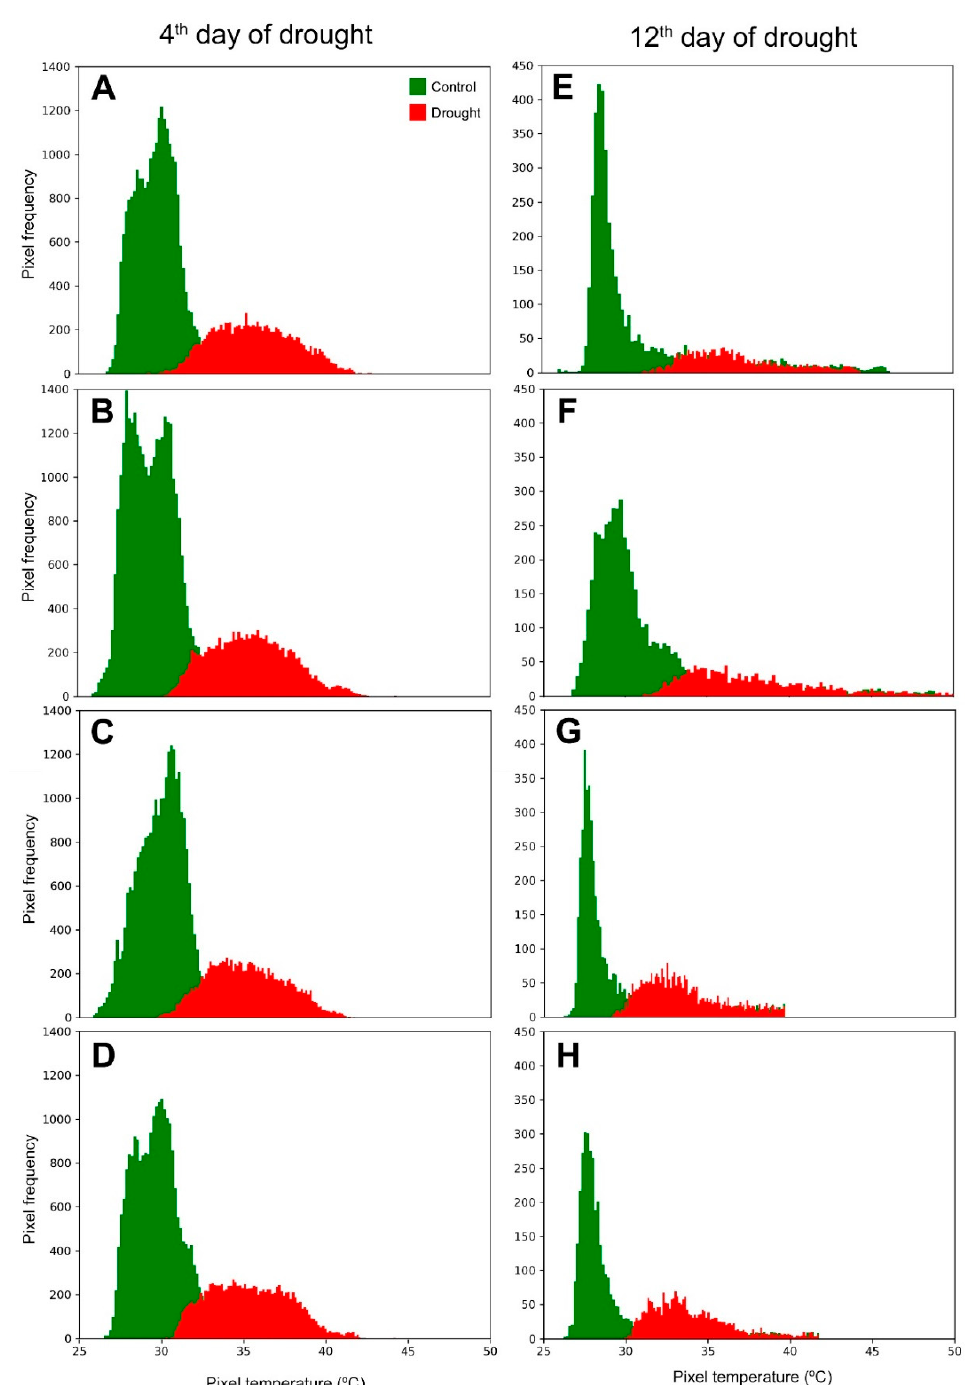
Figure 2. Frequency histogram of canopy pixel temperature for control and drought stressed maize plants. Panels A – D were obtained on the 4th, while E – H were obtained on the 12th day of stress. ( A , E ) BRS 1030; ( B , F ) BRS 1010; ( C , G ) 2B 707; ( D , H ) DKB 390. The pixels were segmented and extracted from thermal images taken at 15 m ( A – D ) and 20 m ( E – H ) AGL.